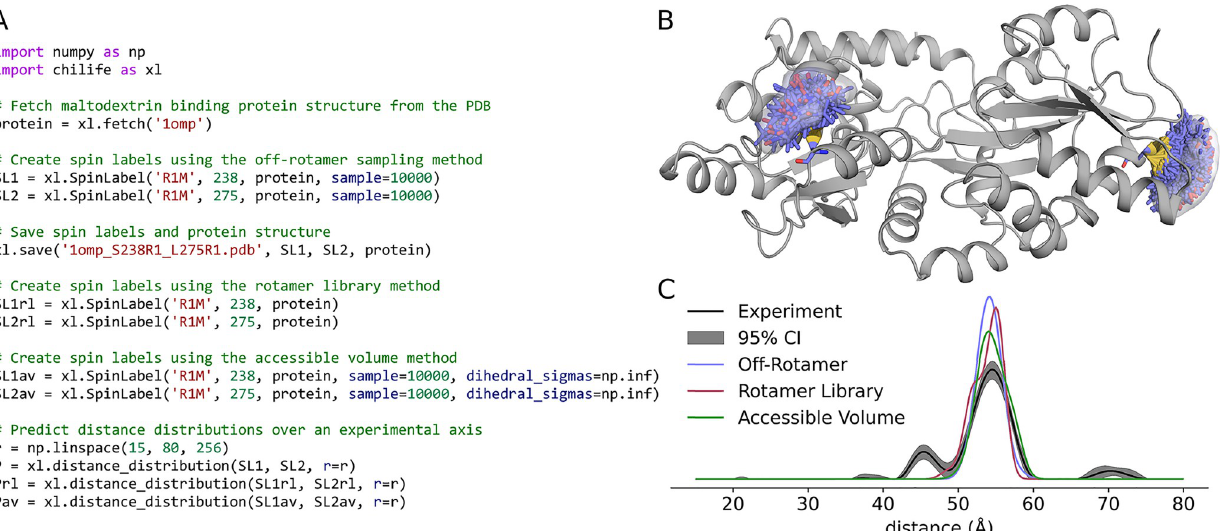
Fig 2. Spin labeling proteins and predicting spin label distance distributions. A) chiLife script. B) Cartoon model of maltose binding protein (PDBID 1OMP) labeled with R1 at sites 238 and 275, showing the spin label ensembles (sticks) and weighted kernel density estimates of the spin centers (semitransparent surfaces). C) Comparison of the predicted distance distributions with the experimental distance distribution.